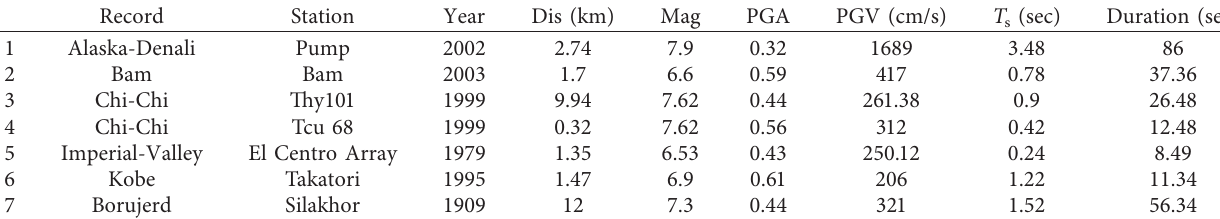
Table 3: Near-field earthquake properties.